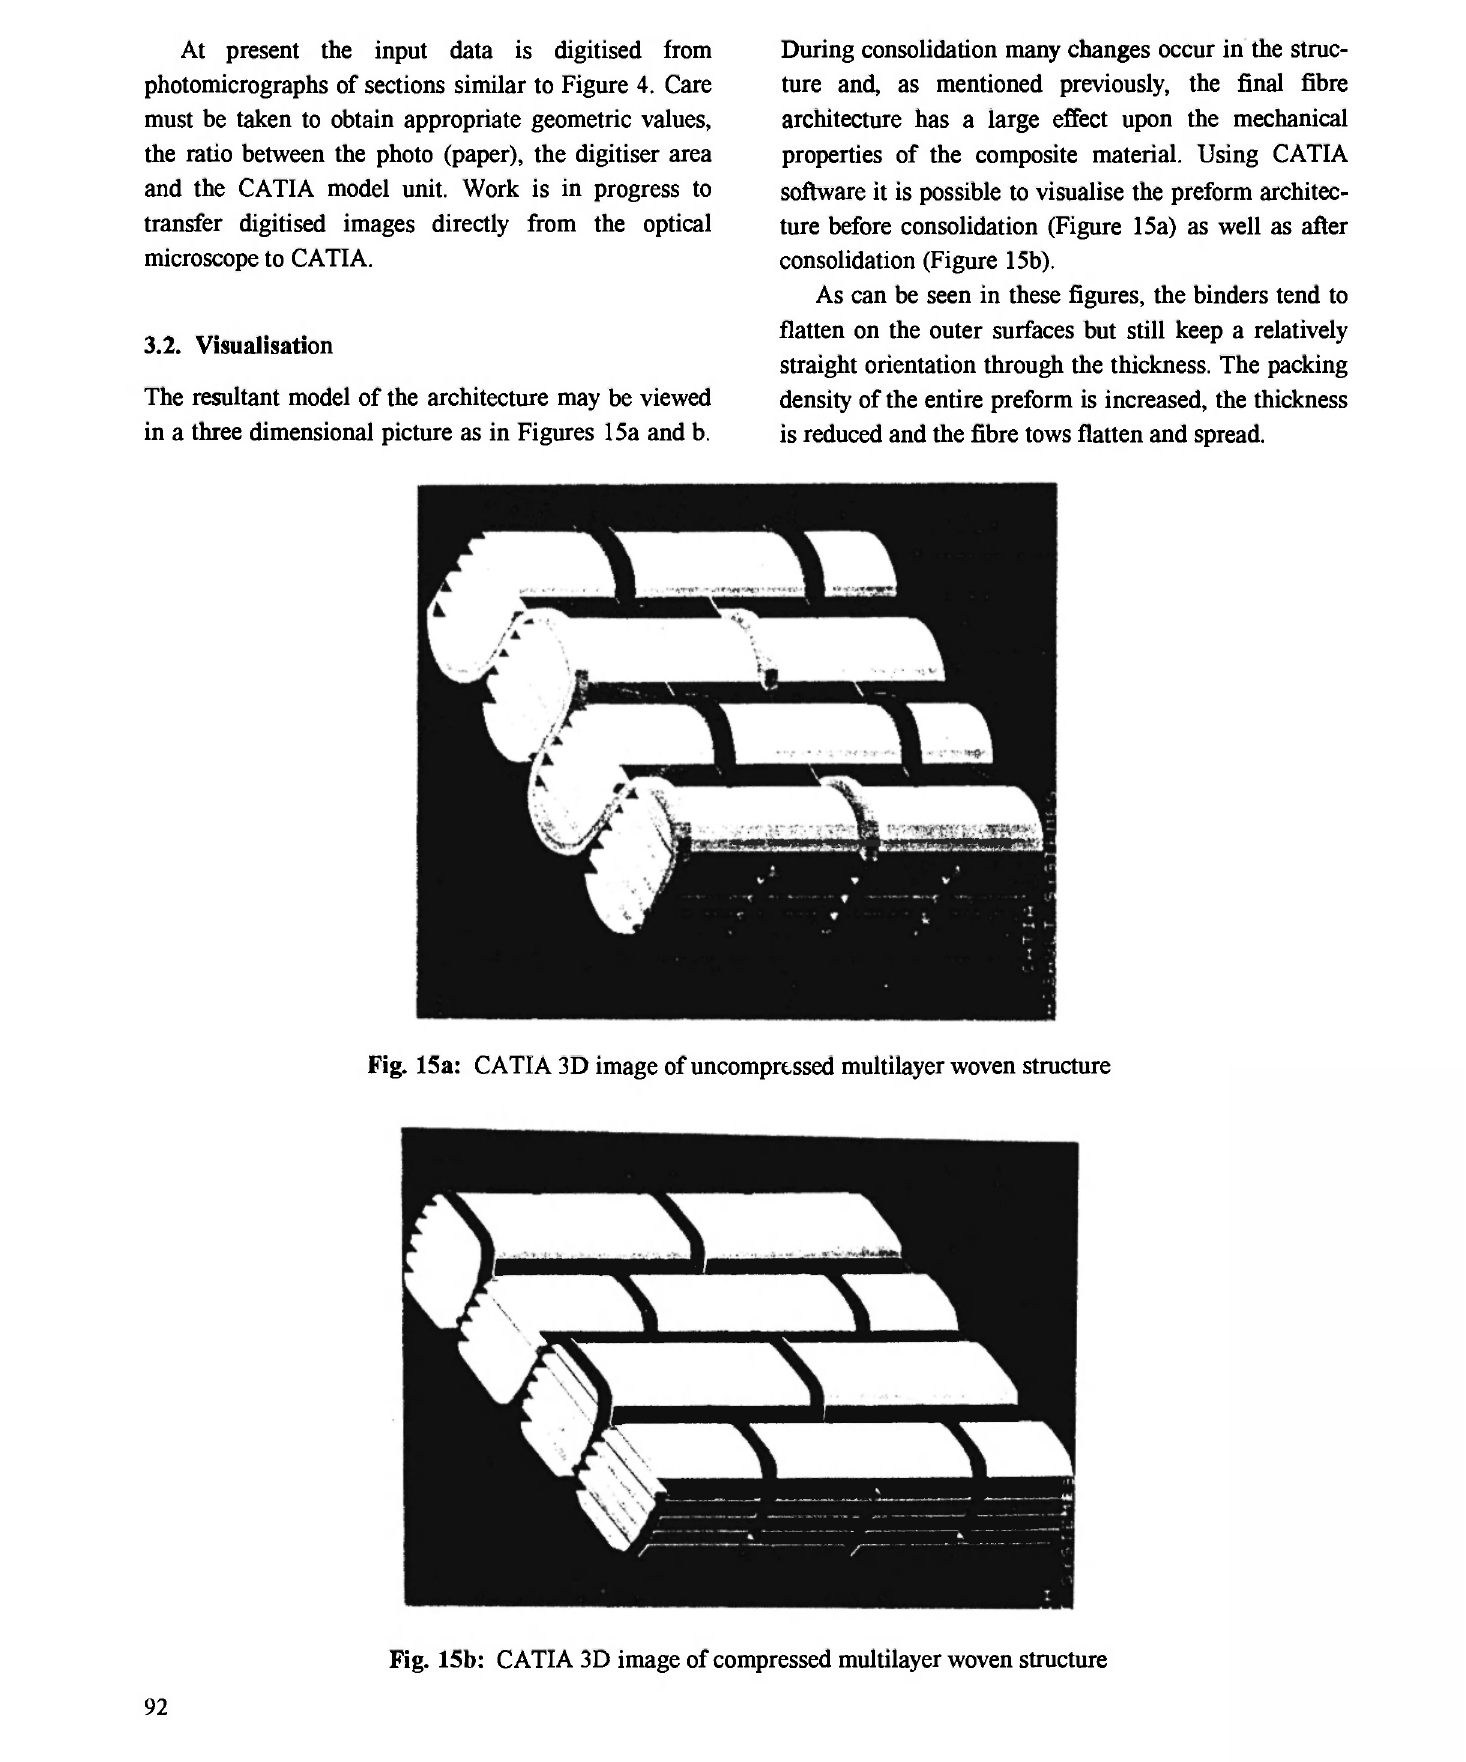
Fig. 15b: CATIA 3D image of compressed multilayer woven